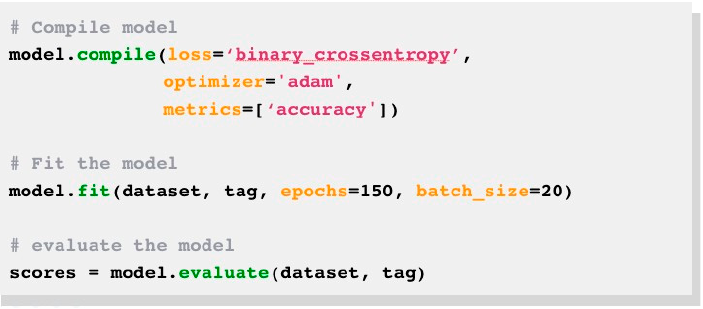
Figure 16. Training ANN model.